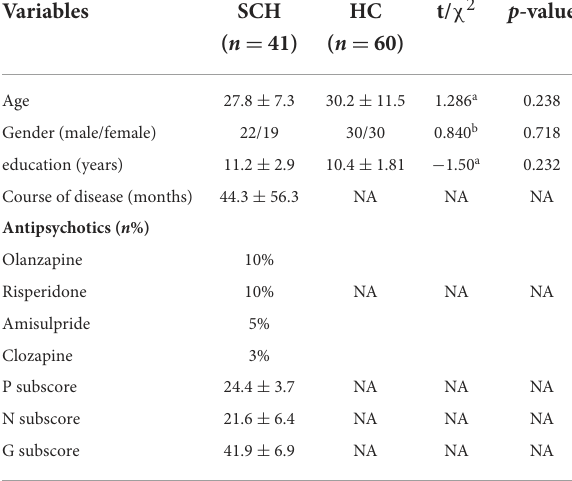
TABLE 1 Demographic and clinical characteristics of SCZ patients and HCs.